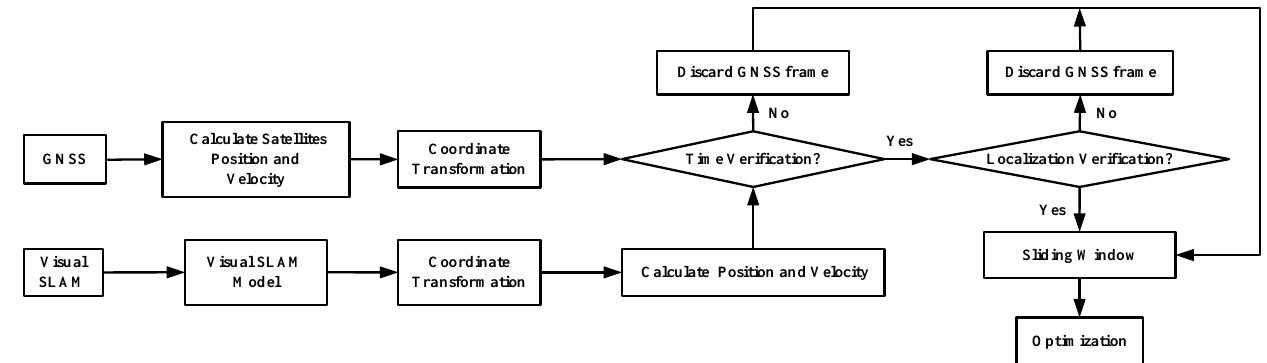
Figure 1. GNSS spoofing identification and smoothing localization model.